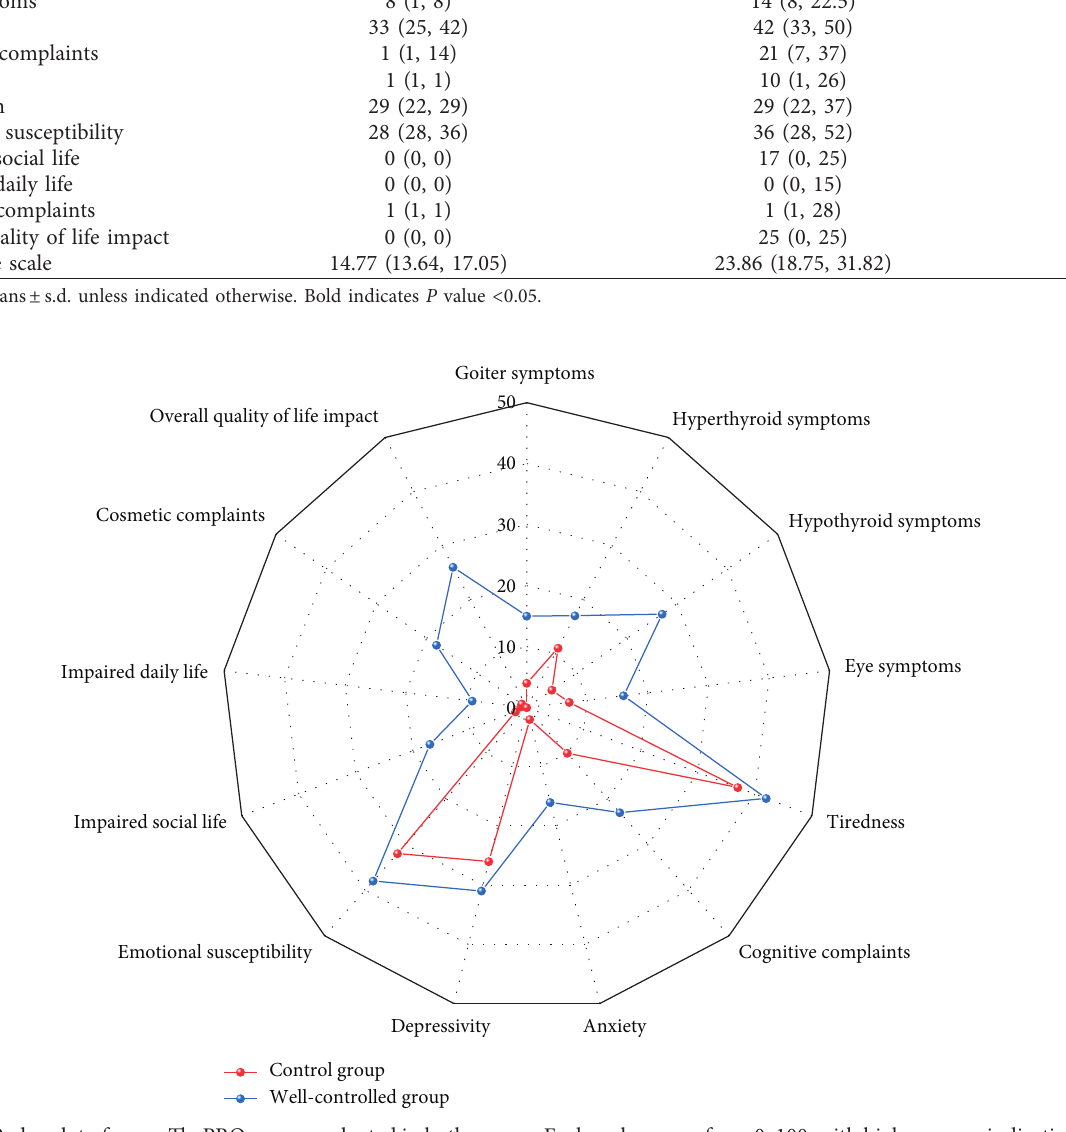
Figure 1: Radar plot of mean ThyPRO scores evaluated in both groups. Each scale ranges from 0–100, with higher scores indicating poorer quality of